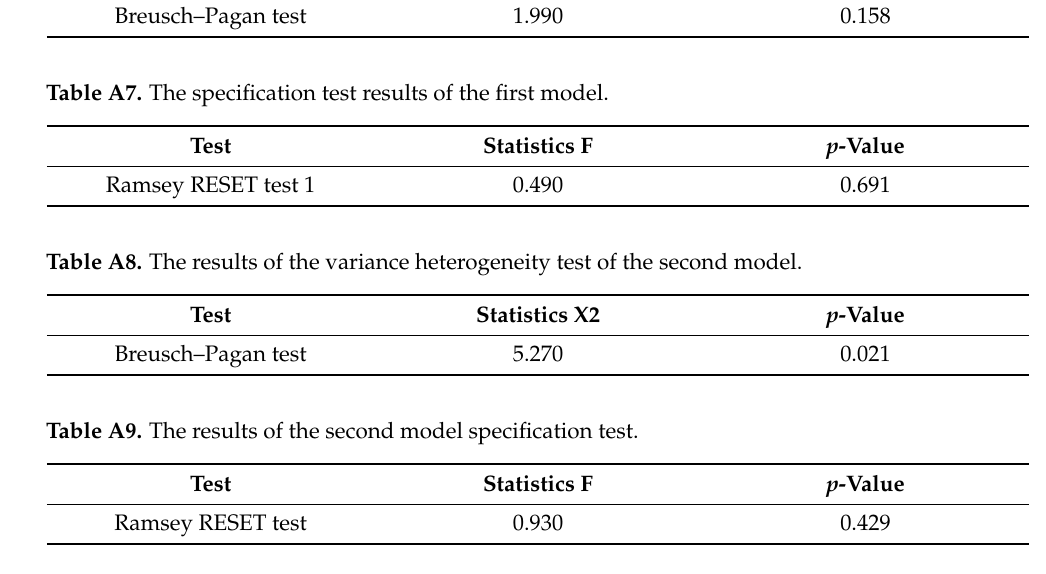
Table A10. The results of the third model variance heterogeneity